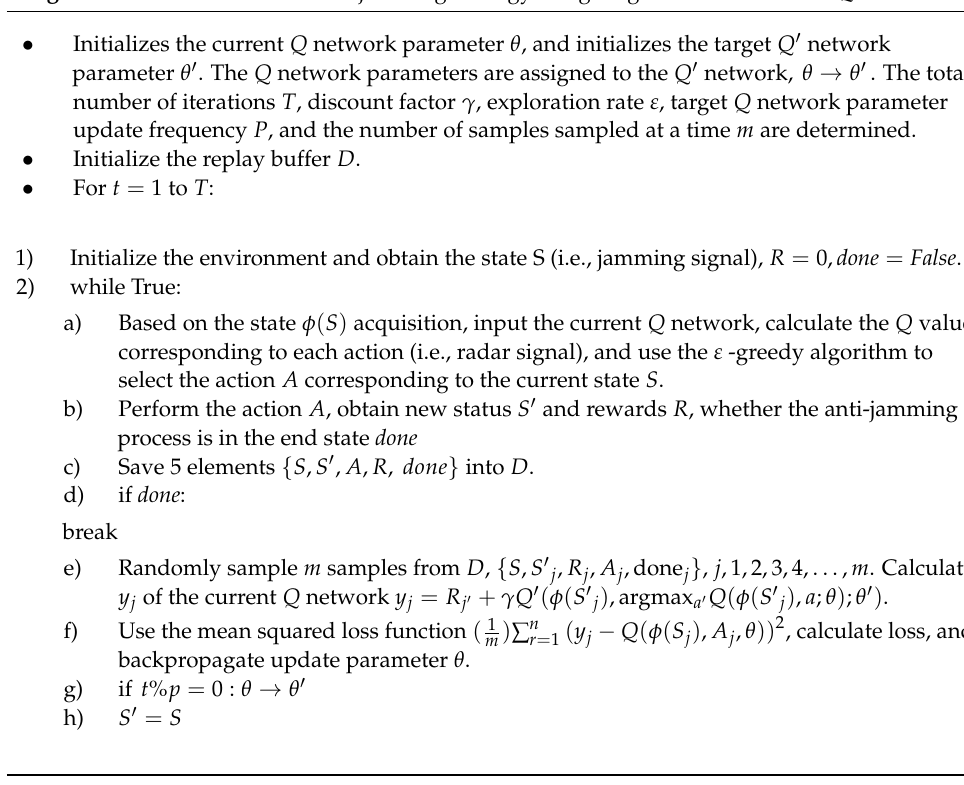
Algorithm 1: Airborne radar anti-jamming strategy design algorithm based on